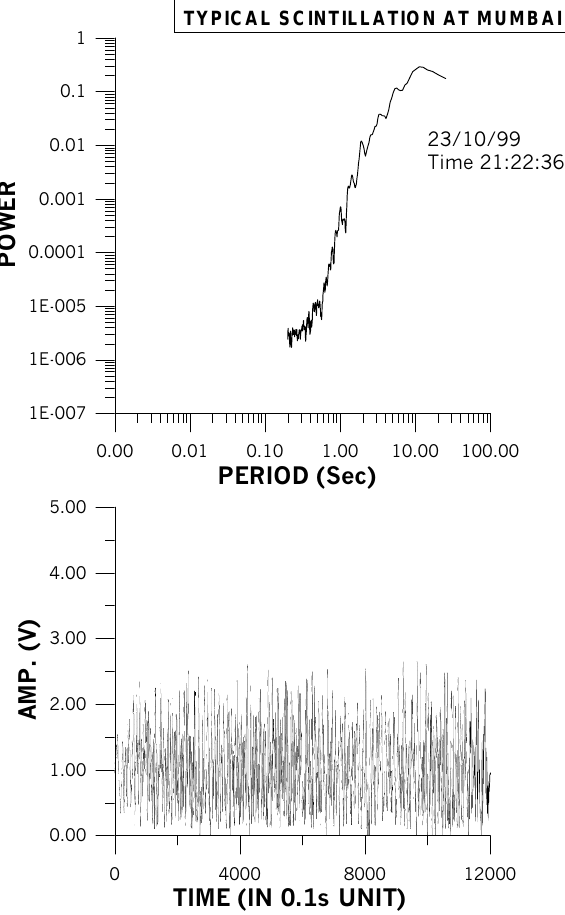
Fig. 2. The lower panel shows a typical scintillation at Mumbai, and the upper panel displays the corresponding power spectrum show- ing that field line eigen-period ( ∼ 25 sec) falls well beyond the Fres- nel